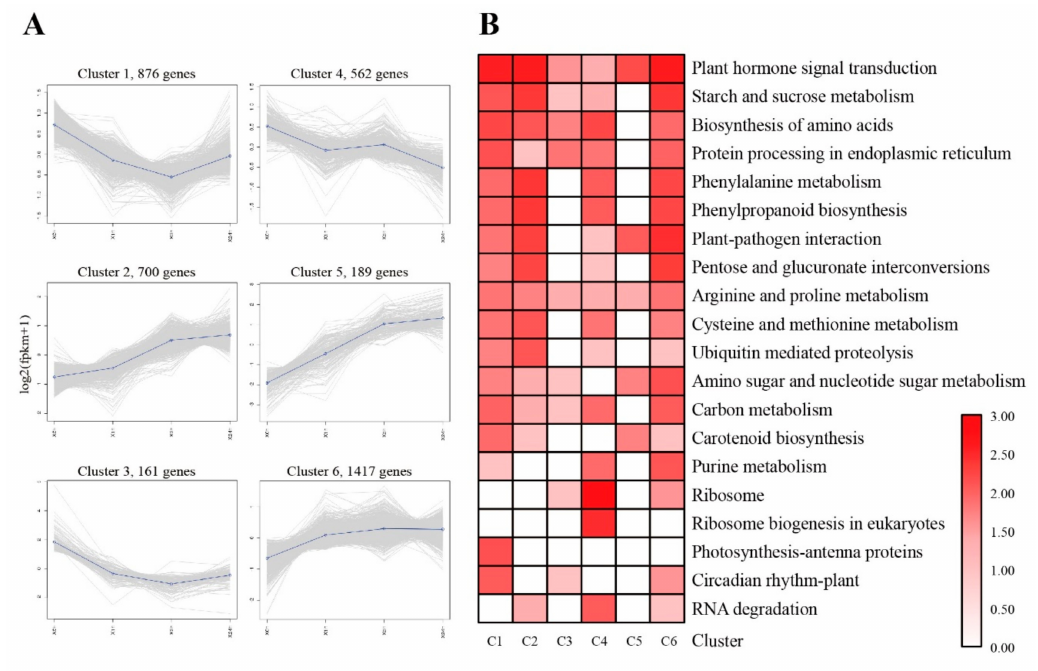
Figure 4. Co-expression clustering showing the expression profile of 3905 DEGs. ( A ) Six major clusters were identified along the time course of cold stress (0, 1, 3 and 24 h). The X-axis represents the time course of freezing stress (0, 1, 3 and 24 h). The Y-axis represents the value of the relative expression level (log2 (FPKM + 1). ( B ) Functional category enrichment among the six major clusters is based on KEGG